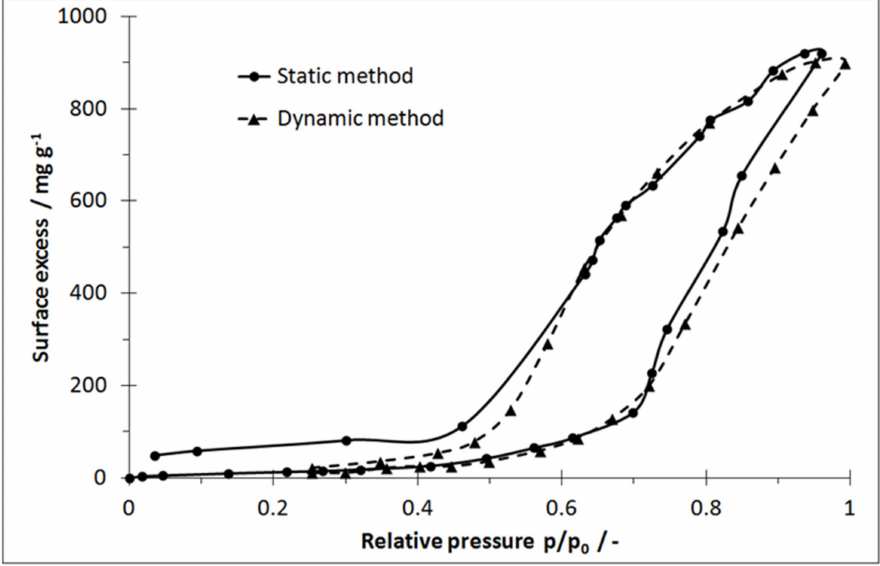
Figure 2. Adsorption of water vapor on BAX 1100 at T = 24 ◦ C, p 0 (24 ◦ C) = 29.8